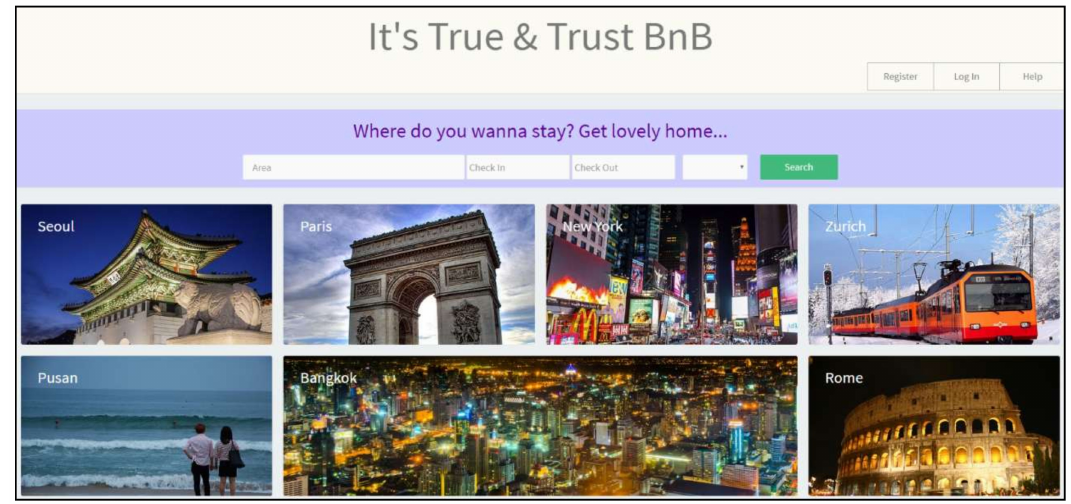
Figure 9. An example of a TIMP-based resource-sharing service (an accommodation service).